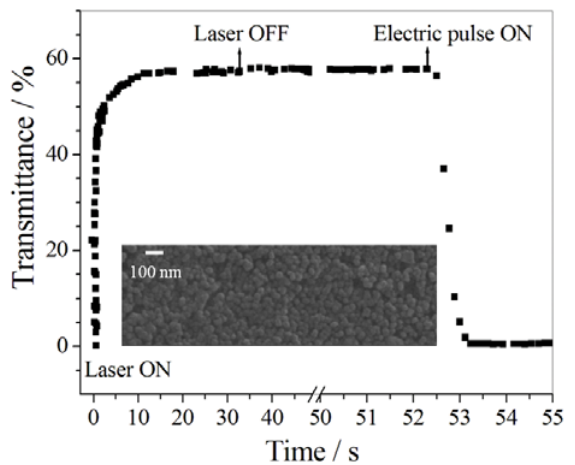
Figure 33. Enhancement in the response of photo-electrochromic devices by using nanostructured